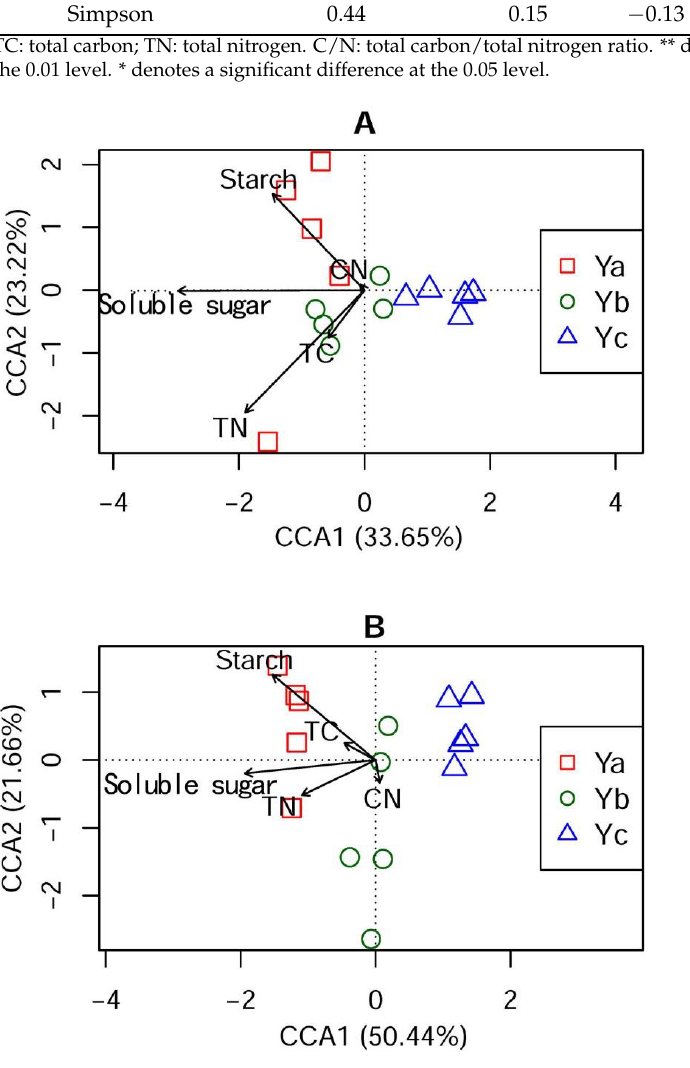
Figure 7. A canonical correlation analysis was used to illustrate the relationships between leaf characteristics and phyllosphere bacterial ( A ) and fungal ( B ) community composition. Ya: healthy Pinus tabuliformis trees; Yb: diseased P. tabuliformis trees at an early stage of B. xylophilus infection; Yc: diseased P. tabuliformis trees in the last stage. TC: total carbon; TN: total nitrogen; CN: total carbon/total nitrogen ratio.